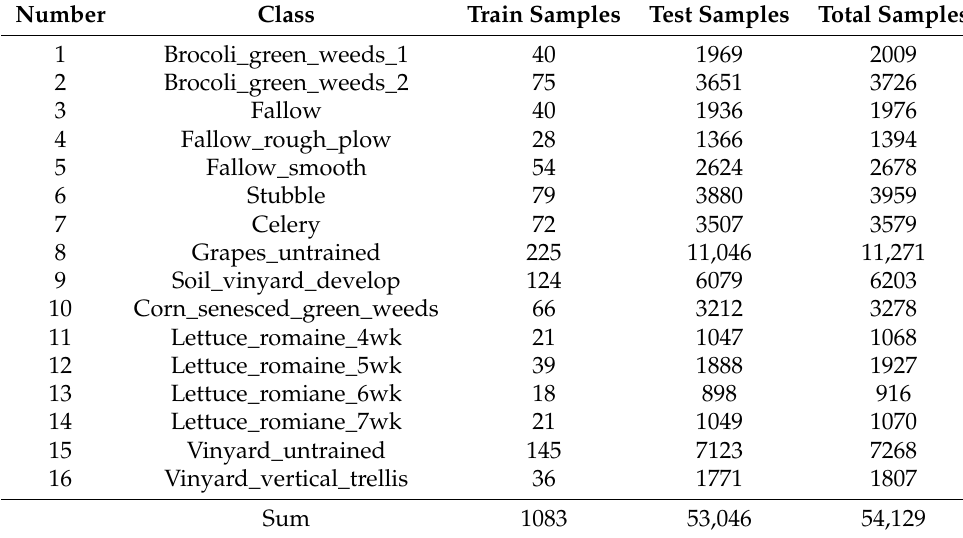
Table 3. The number of samples in the SV dataset.